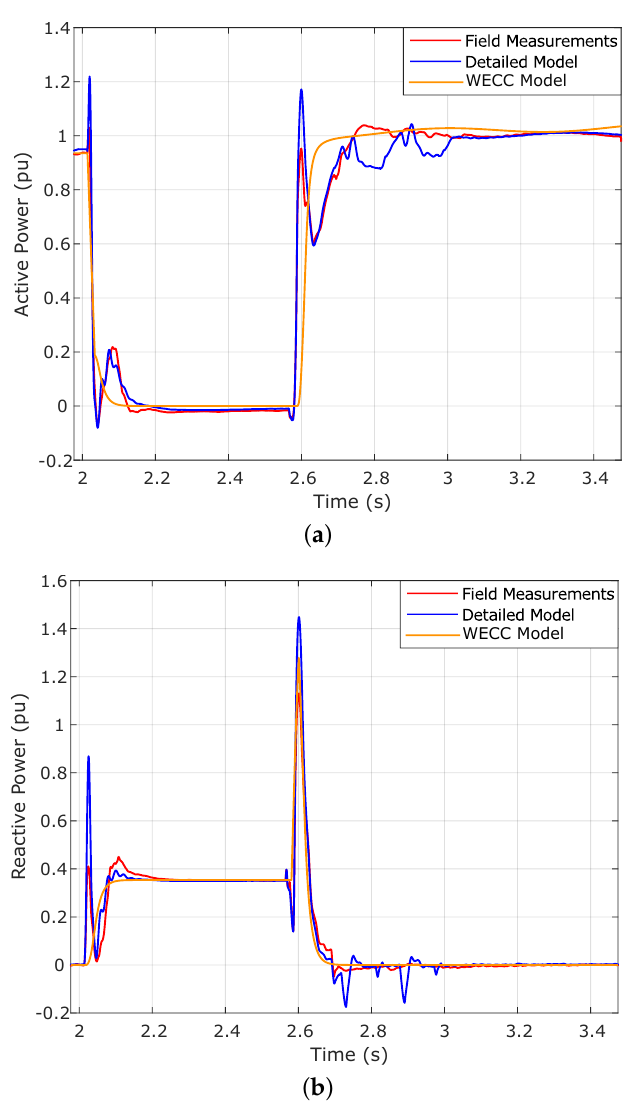
Figure 5. Active and reactive power at measurement point 2 (690 V). WT operating at full load conditions. ( a ) active power; ( b ) reactive